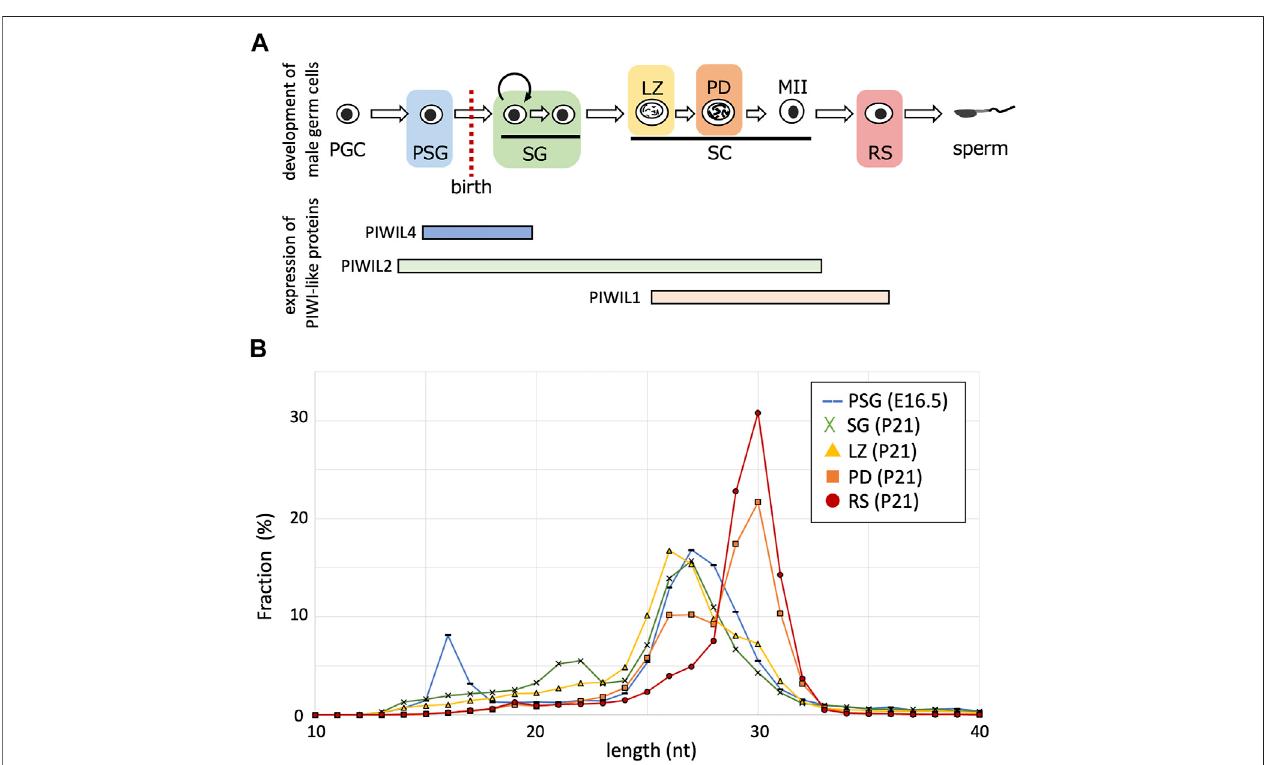
FIGURE 1 | Length distributions of piRNA reads in developing germ cells. (A) The developmental order of male germ cells and the range of PIWI-like protein expression. Their expressions in postnatal germ cells are according to single-cell RNA-seq data (Hermann et al., 2018). PGC, primordial germ cell; PSG, prospermatogonium; SG, spermatogonium; SC, spermatocyte; LZ, leptotene and zygotene stage; PD, pachytene and diplotene stage; MII, meiosis II; RS, round spermatid. (B) Fractions (%) of piRNAs of indicated lengths (10 – 40 nt) in germ cells of different stages (PSG, blue; SG, green; LZ, yellow; PD, orange; RS, red).